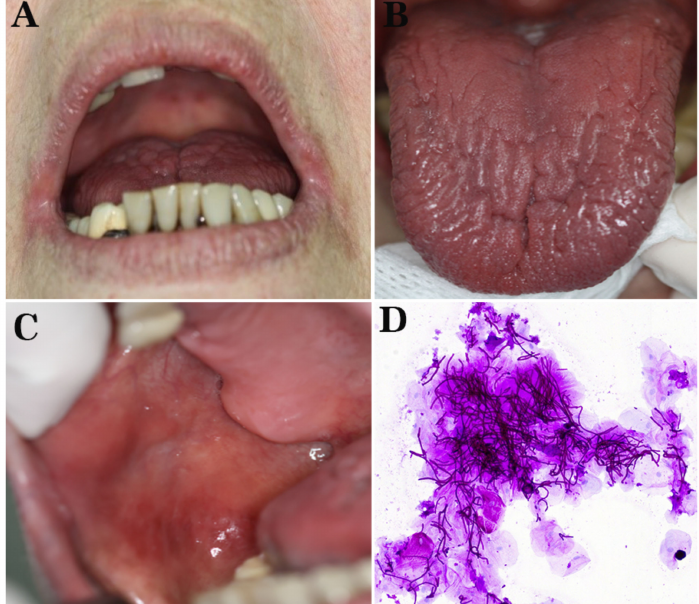
Figure 4. Patient 2. ( A – C ): Clinical examination: dryness and erythema in the labial commissures ( A ), erythematous glossy dorsal tongue ( B ), and diffuse erythema in the right buccal mucosa ( C ). ( D ) A cytology smear from the dorsal tongue demonstrating yeasts of Candida albicans (PAS staining, initial magnification 200 ×